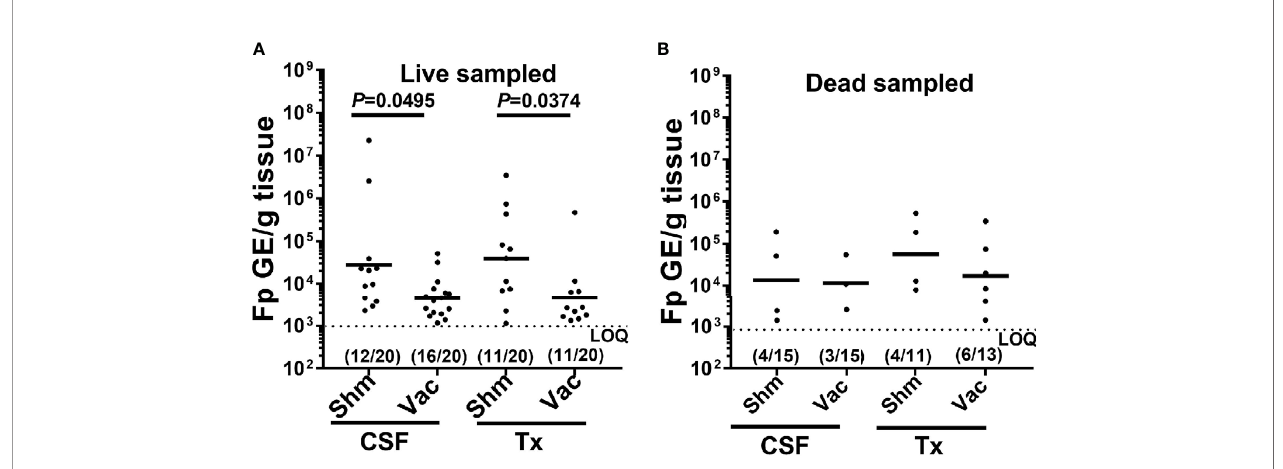
FIGURE 4 | Effect of IHNV vaccination on external F. psychrophilum load. Plots compare F. psychrophilum prevalence and load (Log10 bacterial DNA copies/g tissue) in gill/ fi n samples from vaccinated and sham live-sampled fi sh (A) : days 10 and 12) and mortalities (B) : died between days 8-19) and reared under constant reuse water (Donor and Constant groups combined). Geometric mean indicated by bar and the limit of the F. psychrophilum qPCR assay indicated by dotted line. P-values denote signi fi cant differences between groups. Numbers indicate fi sh positive and total sampled for each